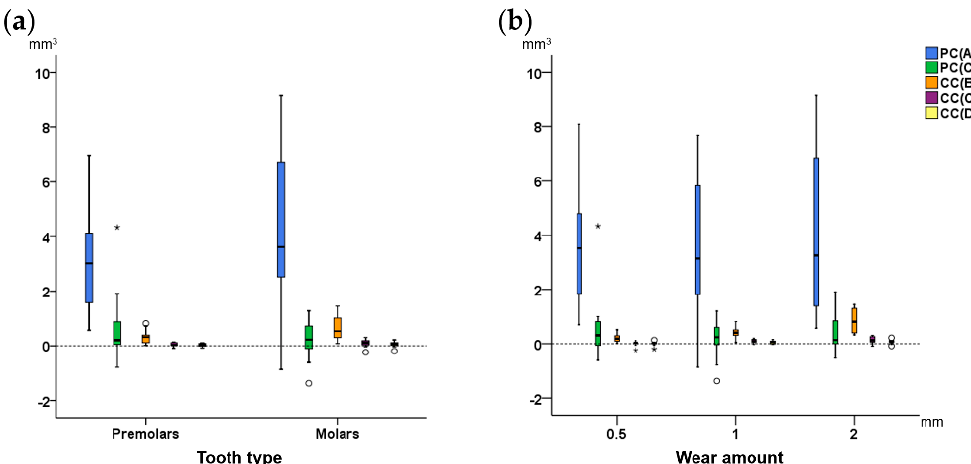
Figure 5. Difference of each technique with the gold standard technique in tooth wear measurements, ( a ) by tooth type, and ( b ) by amount of tooth wear, shown in box plots. The upper limit of the black line represents the maximum value, the lower limit the minimum, the box the interquartile range, and the horizontal black line the median value (trueness). Outliers are shown as black circles ( ◦ ) or asterisks (*), in more extreme cases, with a step of 1.5 × IQR (interquartile range). Zero value (dashed horizontal line) indicates perfect agreement with the gold standard. The vertical length of each plot indicates precision.